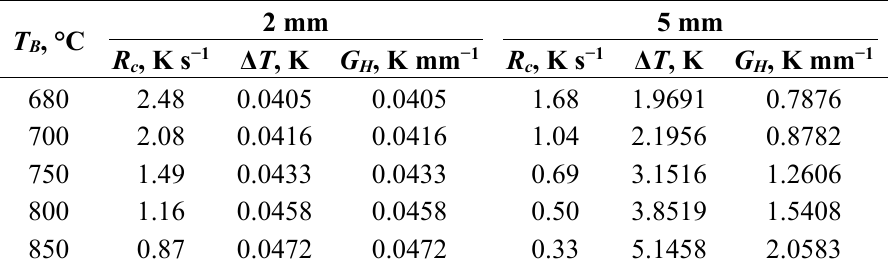
Table 2. R c , Δ T , and G H of different beginning temperatures ( T B ) for the two geometries of thin-walled